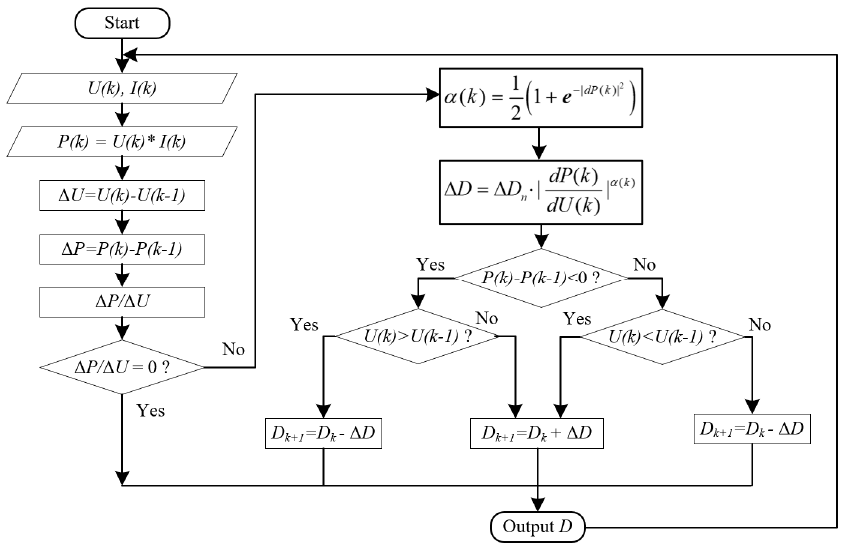
Figure 2. Electrical characteristics of PV array at 25 °C. ( a ) Current versus voltage curve under different radiation; ( b ) power versus voltage curve under different radiation.